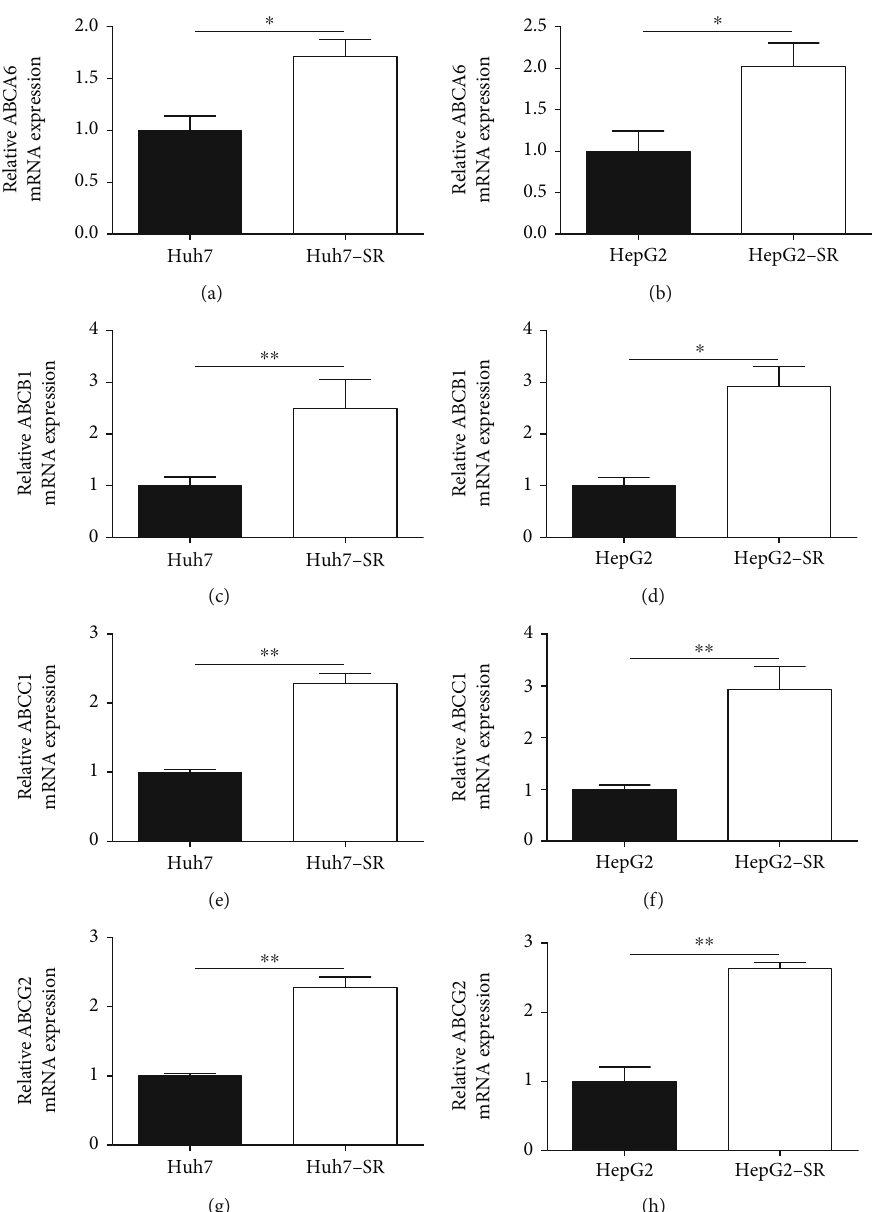
Figure 7: ABCA6, ABCB1, ABCC1, and ABCG2 expression was upregulated in the sorafenib-resistant HCC cell lines. (a, b) Relative mRNA expression of ABCA6 in Huh7, Huh7-SR, HepG2, or HepG2-SR cells. (c, d) Relative mRNA expression of ABCB1 in Huh7 and Hun7-SR cells. (e, f) Relative mRNA expression of ABCC1 in Huh7, Huh7-SR, HepG2, or HepG2-SR cells. (g, h) Relative mRNA expression of ABCG2 in Huh7, Huh7-SR, HepG2, or HepG2-SR. N = 3 . ∗ P < 0 : 05 ; ∗∗ P < 0 : 01